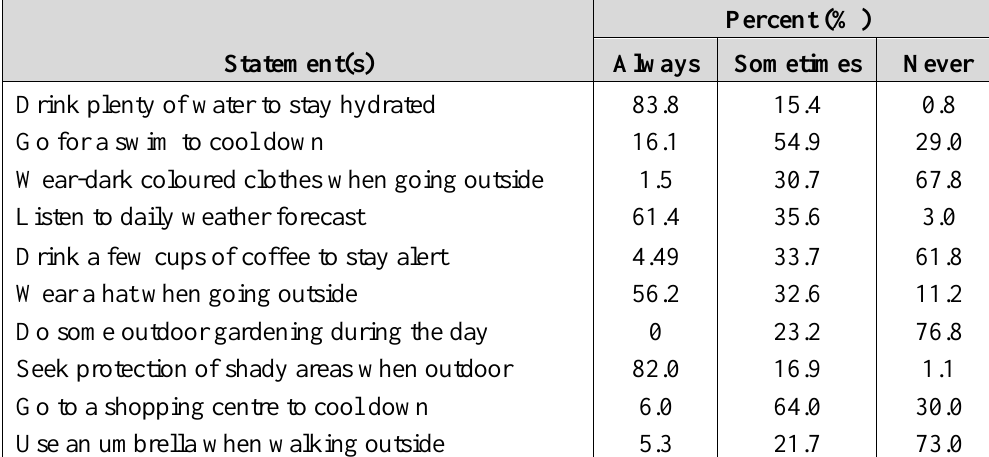
Table 6. Participants’ responses to statements on adaptive